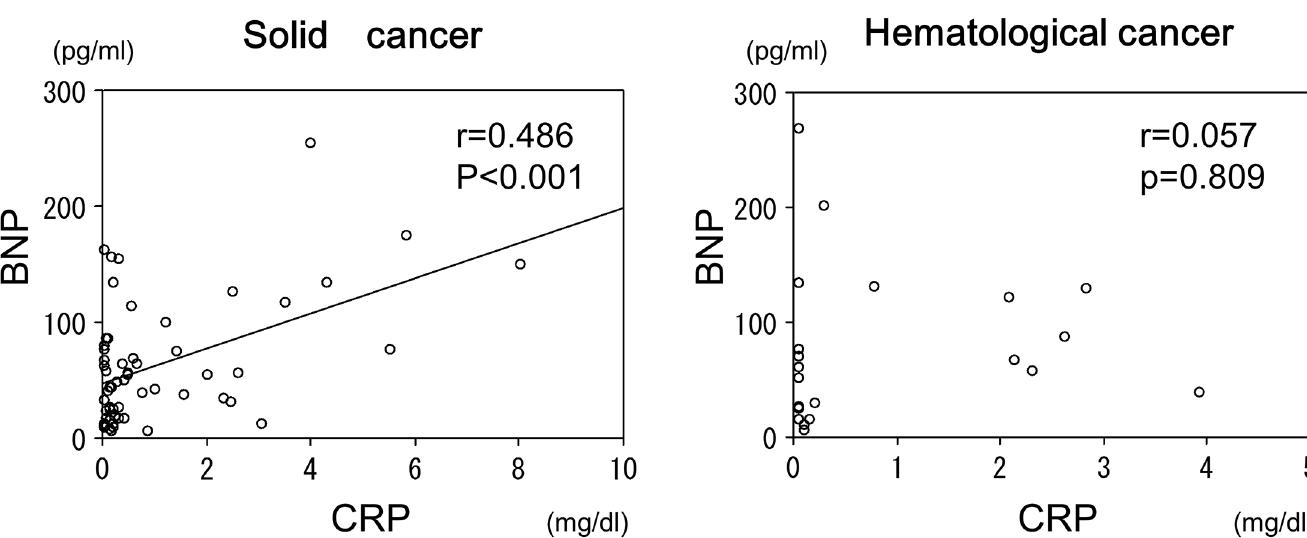
Fig 5. Relationship between the BNP and CRP levels in the patients with hematological cancersversus solid tumors. In the patients with hematological cancers, there was no relationshipbetweenthe BNP and CRP levels. In contrast, there was a significantrelationshipbetweenthe BNP and CRP levels in the patients with solid tumors.